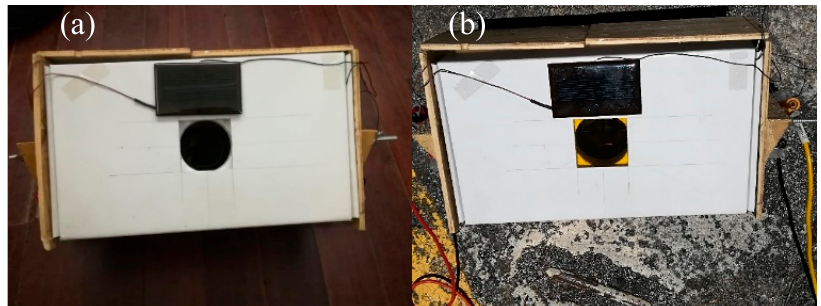
Figure 6. Structure. ( a ) No high-pass (HP) filters; ( b ) with HP filters.